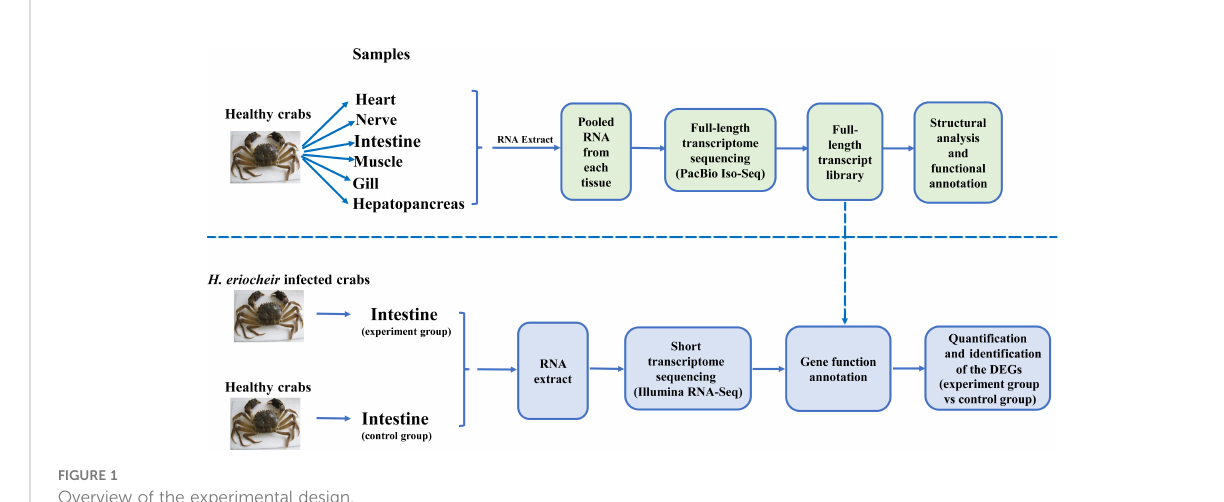
FIGURE 1 Overview of the experimental